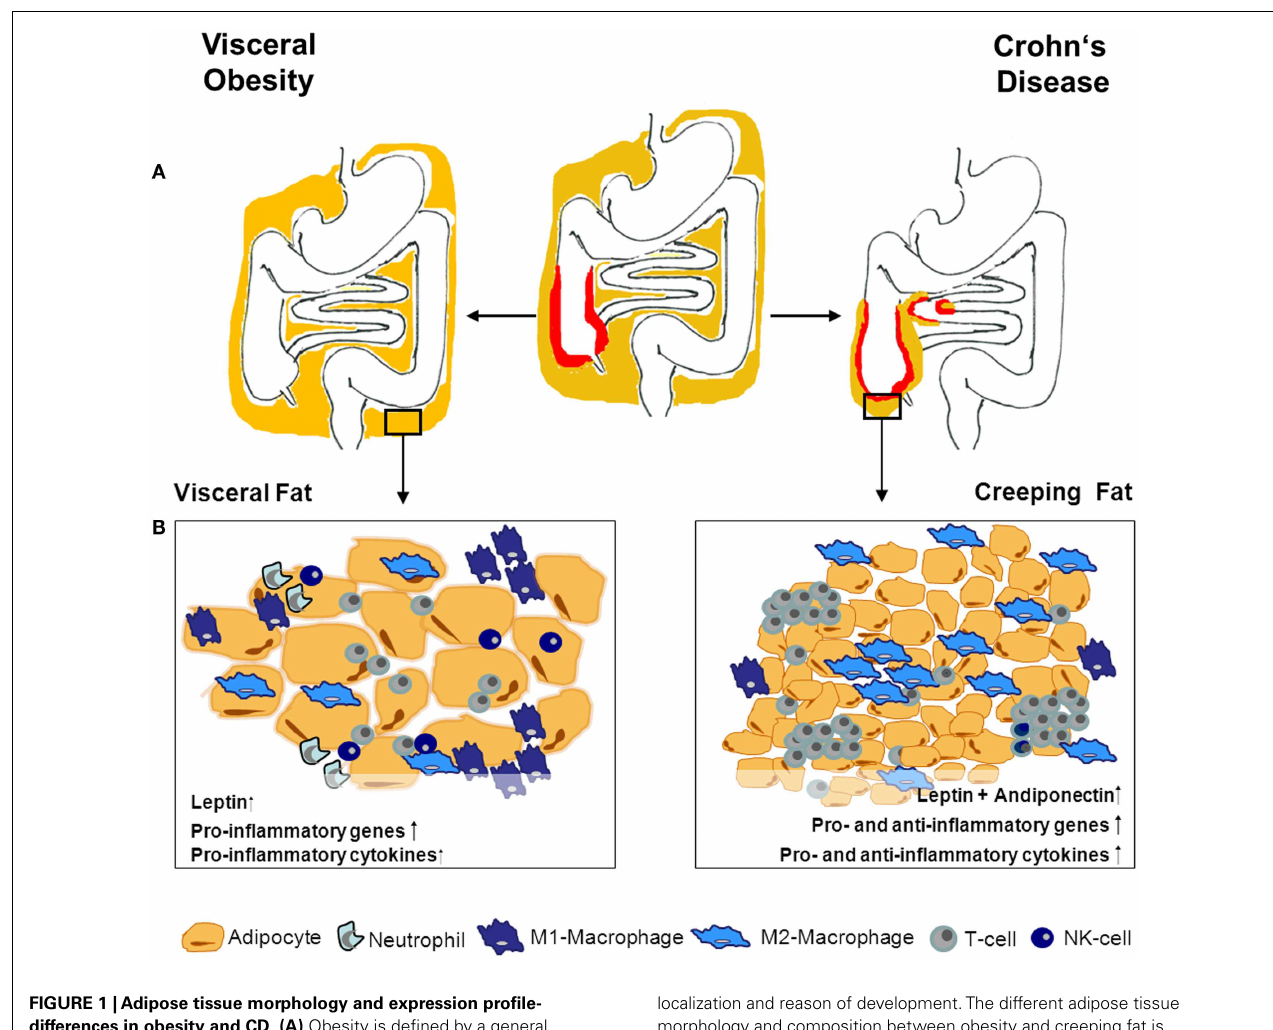
FIGURE 1 |Adipose tissue morphology and expression profile- differences in obesity and CD . (A) Obesity is defined by a general enlargement of adipose tissue. Especially, the visceral fat-tissue undergoes drastic humoral and cellular changes in obese compared to lean individuals. In Crohn’s disease (CD), adipose tissue accumulation is localized around the inflamed intestinal segments.The interplay between adipose tissue and immune cells during inflammation within the tissue is the subject of ongoing research. Given the differences between adipose tissue in CD and obesity, obese CD patients’ adipose tissue might have varying impact on the intestinal inflammation depending on its